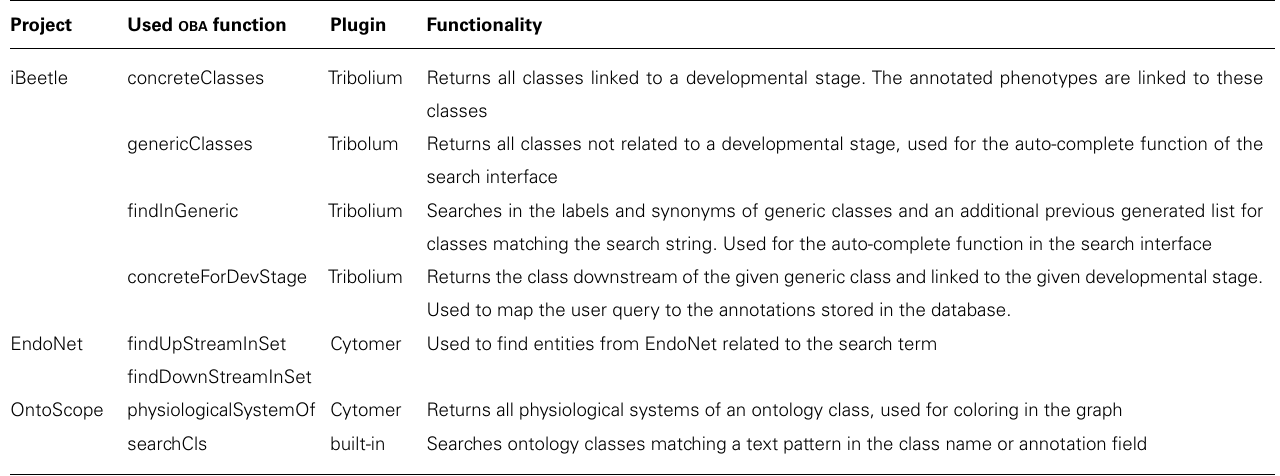
Table 2 | Overview of the OBA functions used in the projects.